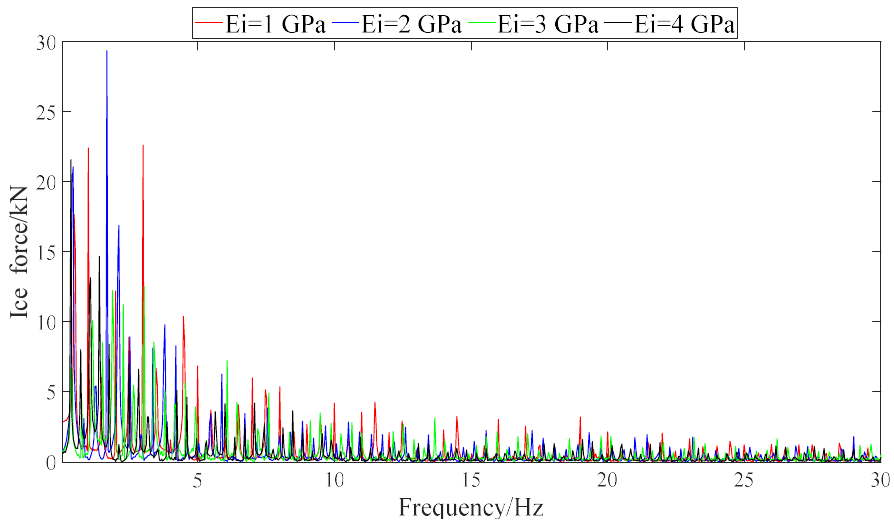
Figure 29. Frequency domain curves with different Young’s modulus ( E i ). Table 11. Statistics of ice force under different Young’s modulus ( E i